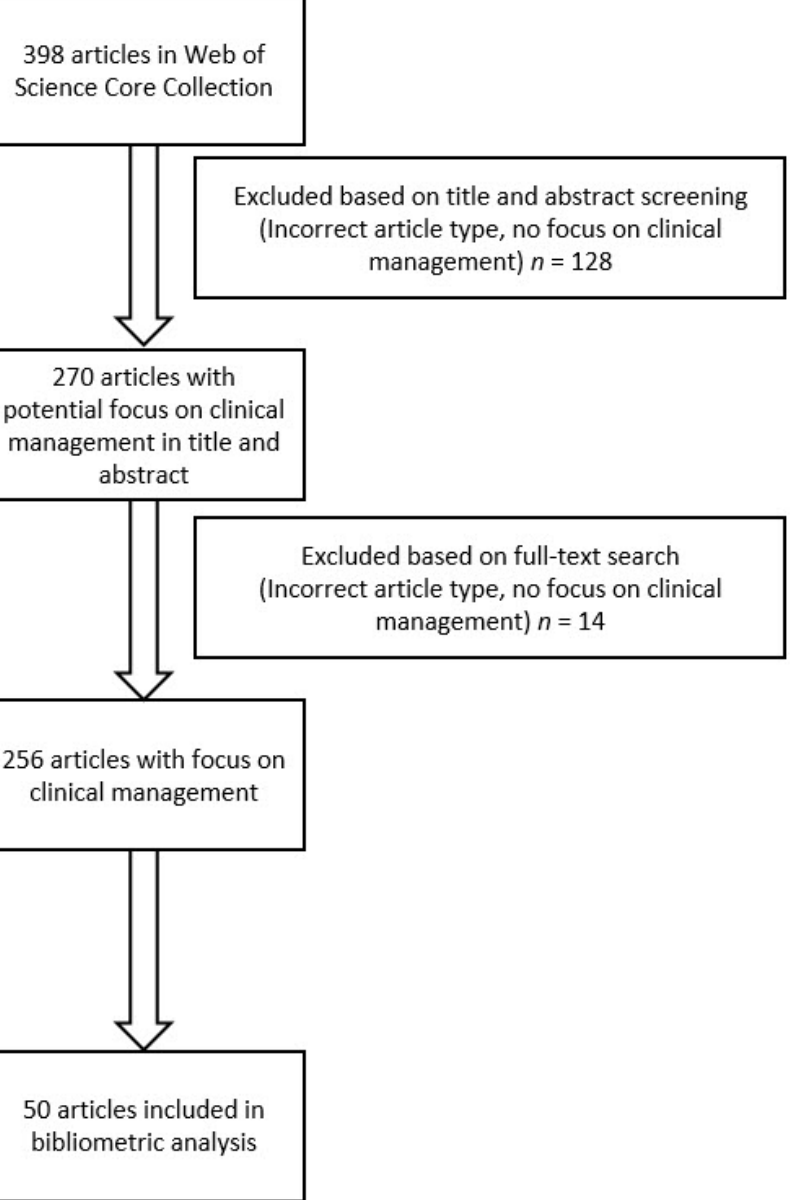
Figure 1. Flowchart of the selection process .